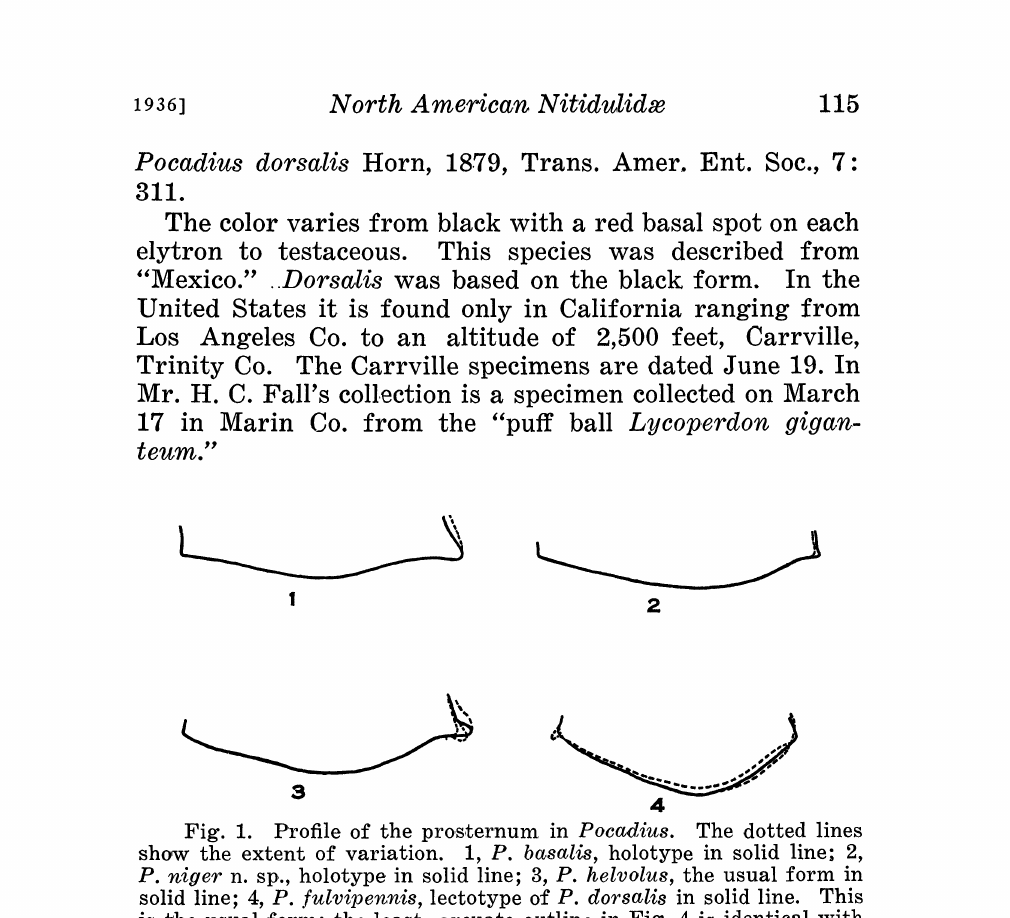
Fig. 1. Profile of the pro.sternum in Pocadius. The dotted lines showy the extent of variation. 1, P. ba.salis, holotype in solid line" 2, P. niger n. sp., holotype in solid line; 3, P. helvalus, the usual form in solid line; 4, P. fulvipennis, lectotype of P. dorsalis in solid line. This is thee. usual form; the least arcuate outline in Fig. 4 is identical with that of the European P.